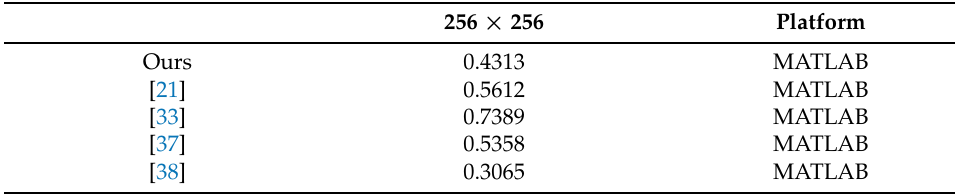
Table 6. The encryption time for different algorithms (seconds).